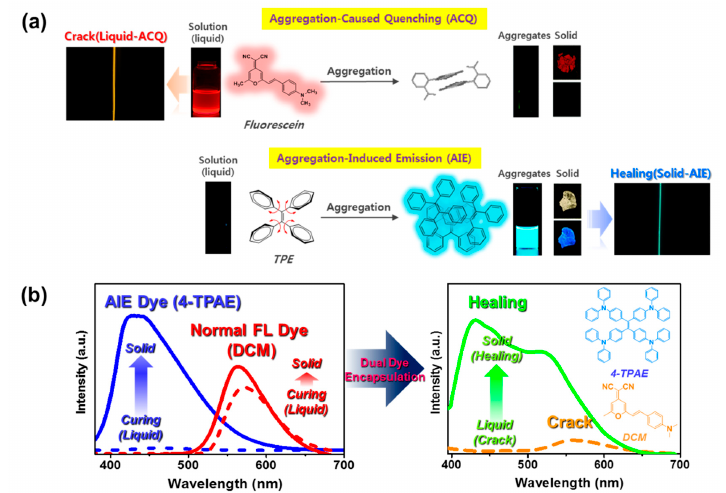
Figure 2. ( a ) Schematic of cracking (aggregation-caused quenching, ACQ) and healing (aggregated- induced emission, AIE) detection using microcapsules loaded with dyes. ( b ) Fluorescence spectrum at 365 nm excitation of the AIE dye (4-TPAE), normal dye (DCM), and 4-TPAE/DCM mixture before and after curing.